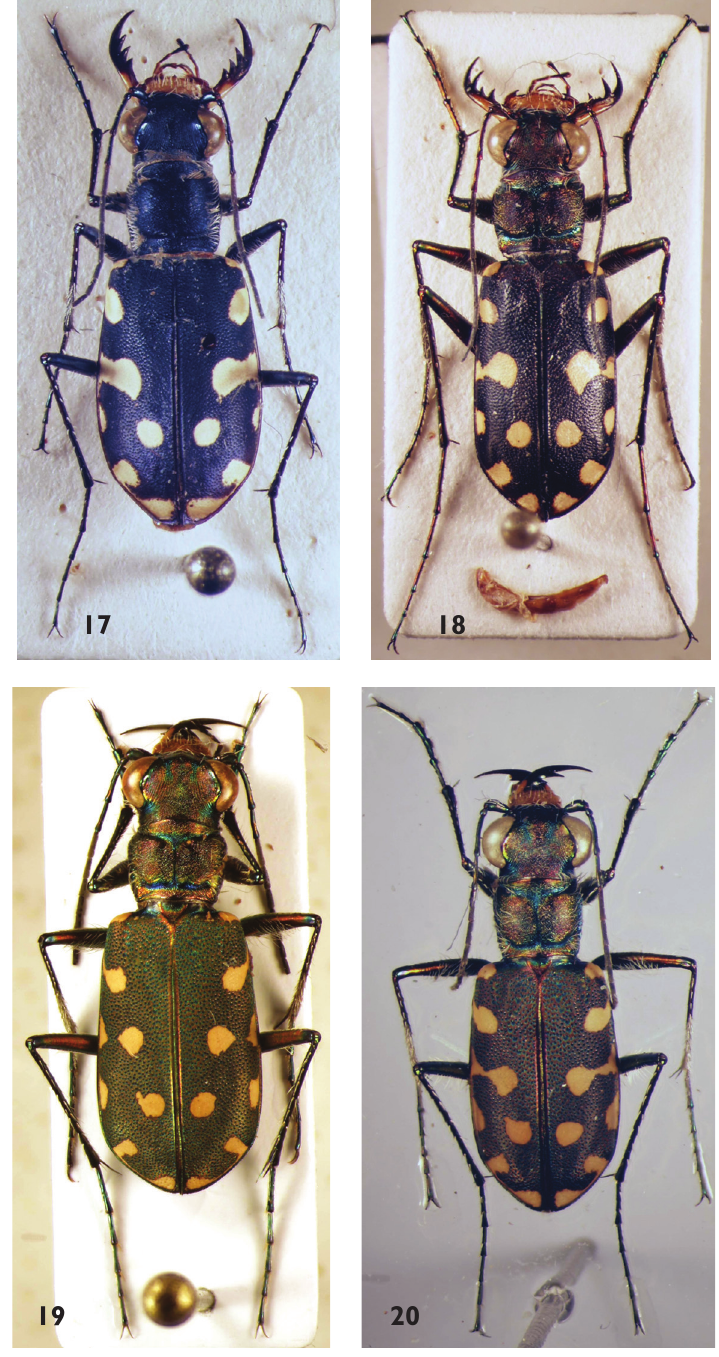
Figures 17–20. Calomera species: 17 C. diania (male) 18 C. aphrodisia (male) 19 C. littoralis winkleri (male) 20 C. aulicoides